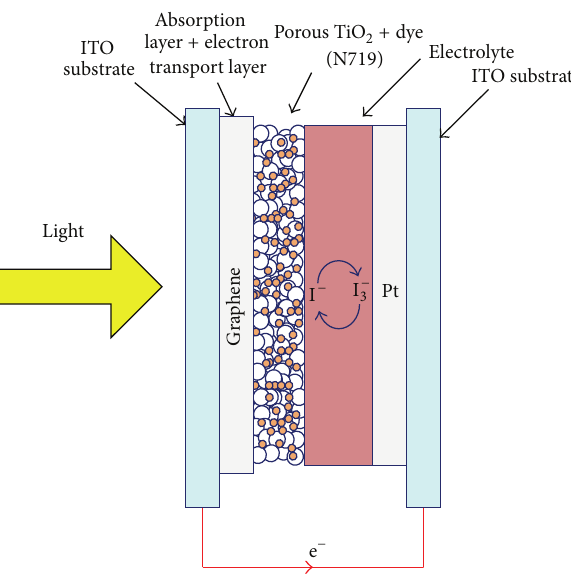
Figure 1: Schematic cross-section of the completed structure.